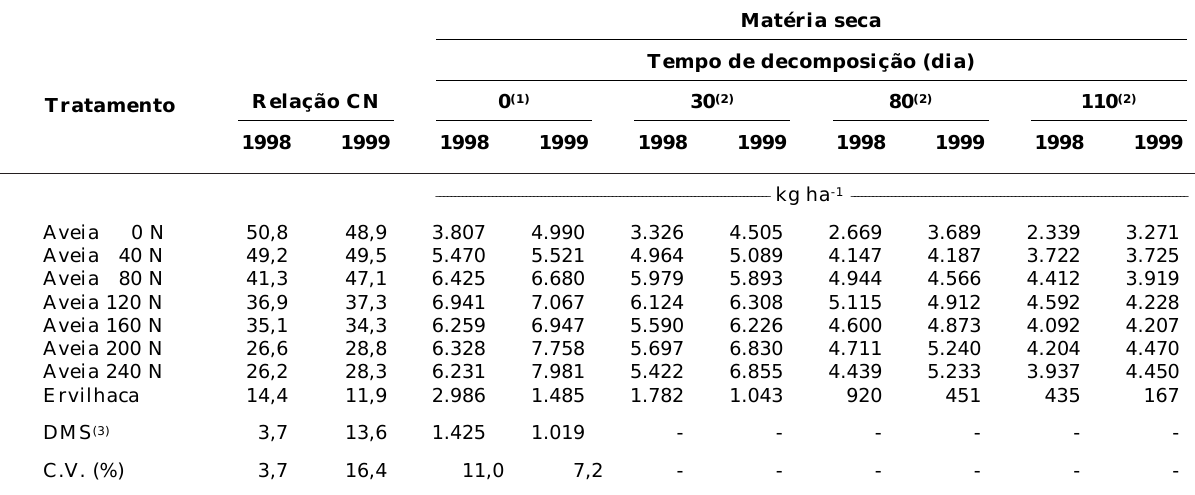
Quadro 2. Relação C/N e matéria seca dos resíduos da aveia preta e da ervilhaca, durante o ciclo